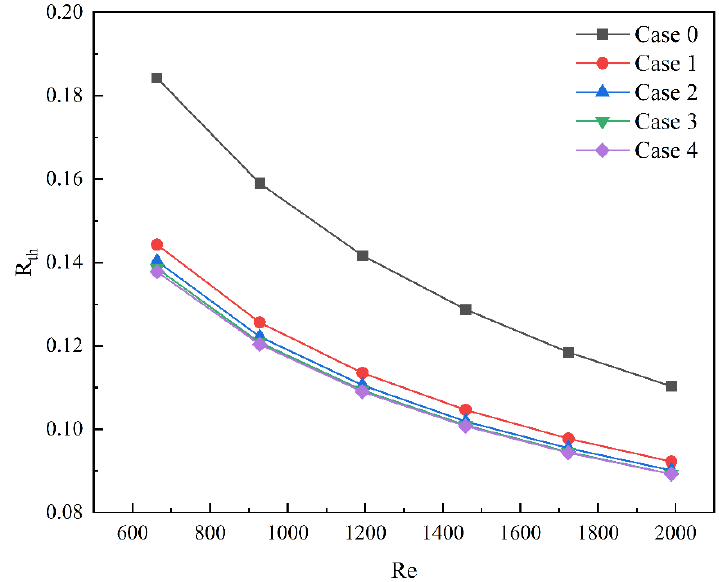
Figure 12. The thermal resistance of Case 0–4 at different Reynolds numbers.